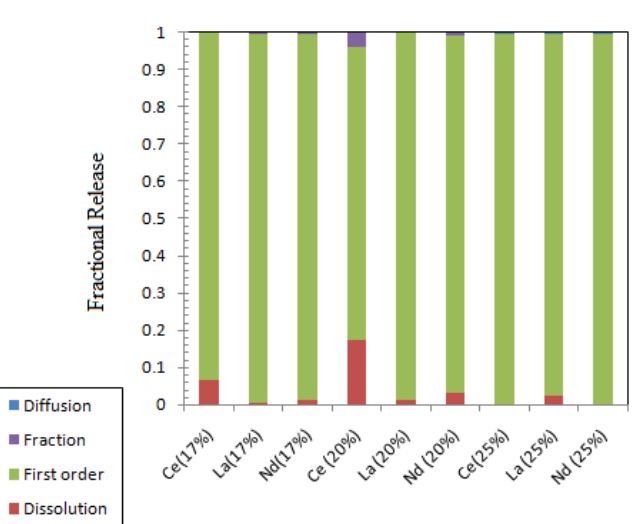
ff erent leaching processes to the fractional release of rare earth Figure 10. Contribution of different leaching processes to the fractional release of rare earth elements. Figure 10. Contribution of di